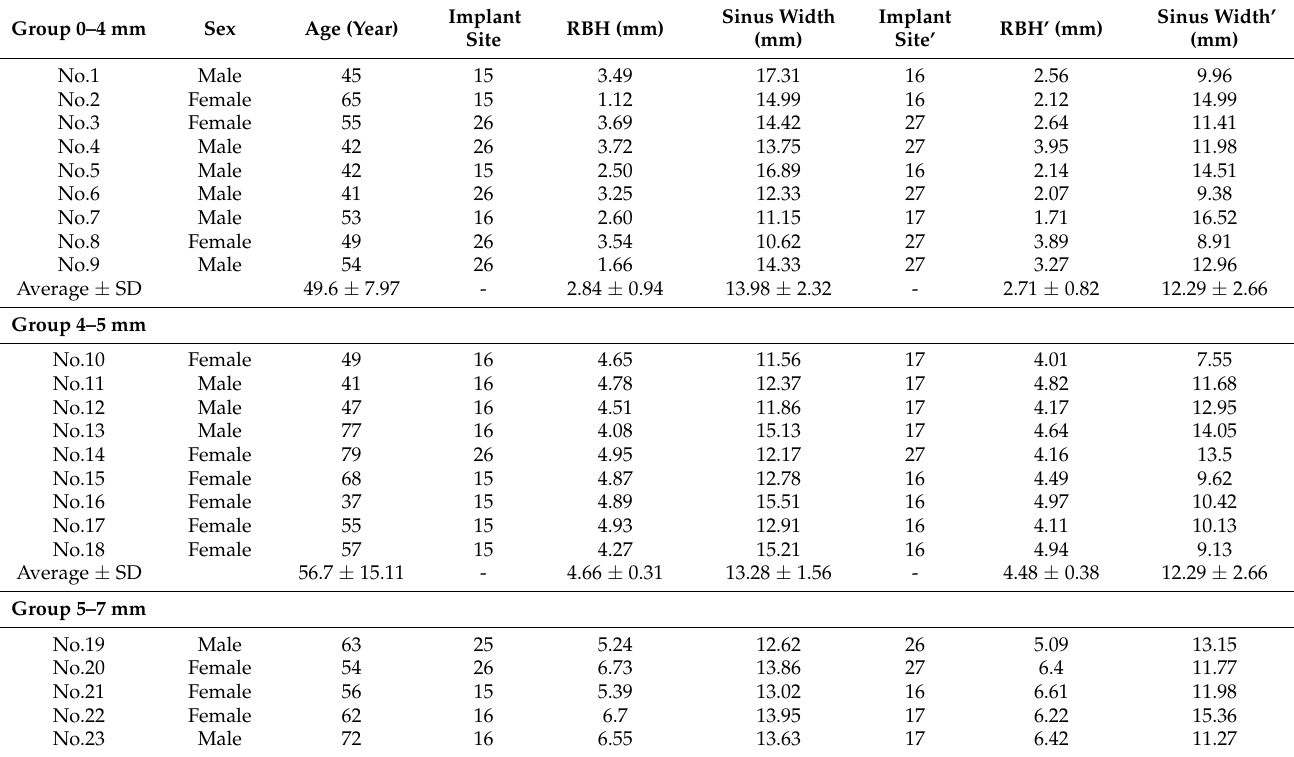
Table 1. Preoperative patient and bone